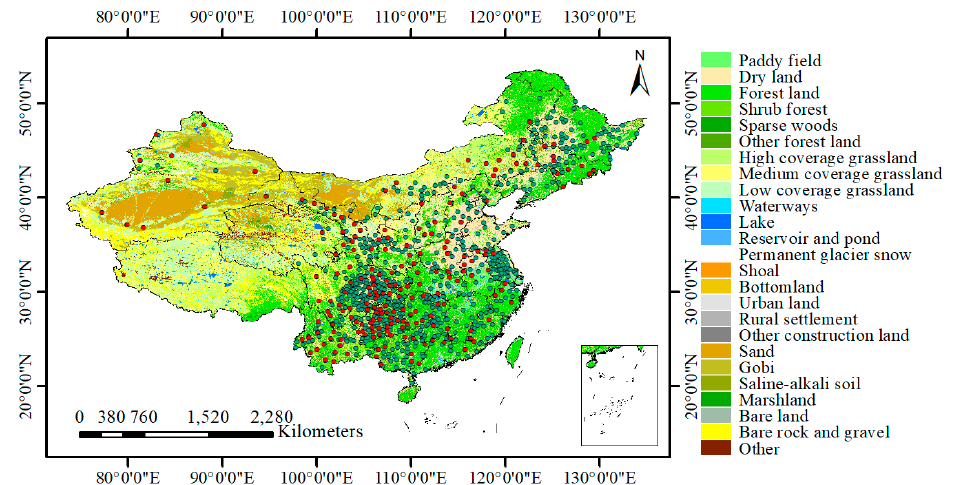
Figure 2. Locations of the 893 monitoring stations projected onto the land cover map of China. The green points represent soil moisture stations, and the red points represent stations with both SM and climate data. The classification standards for land cover are described in Section 2.1.5.